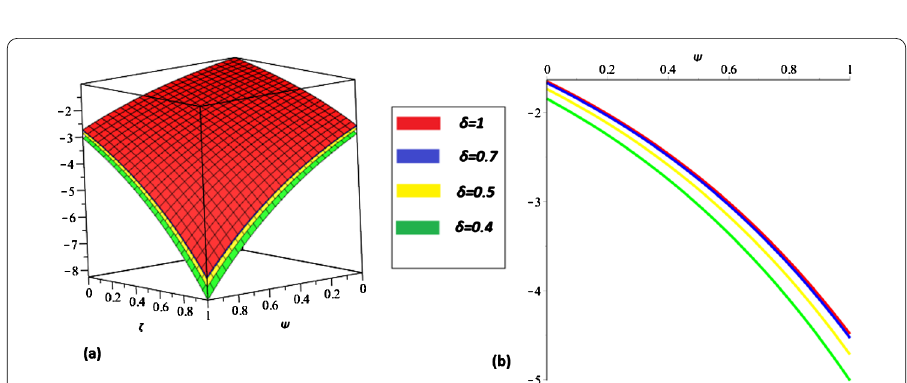
Figure 4 The ( a ) ETDM μ -solution of example 2 at different fractional orders of δ ( b ) ζ = 0.5